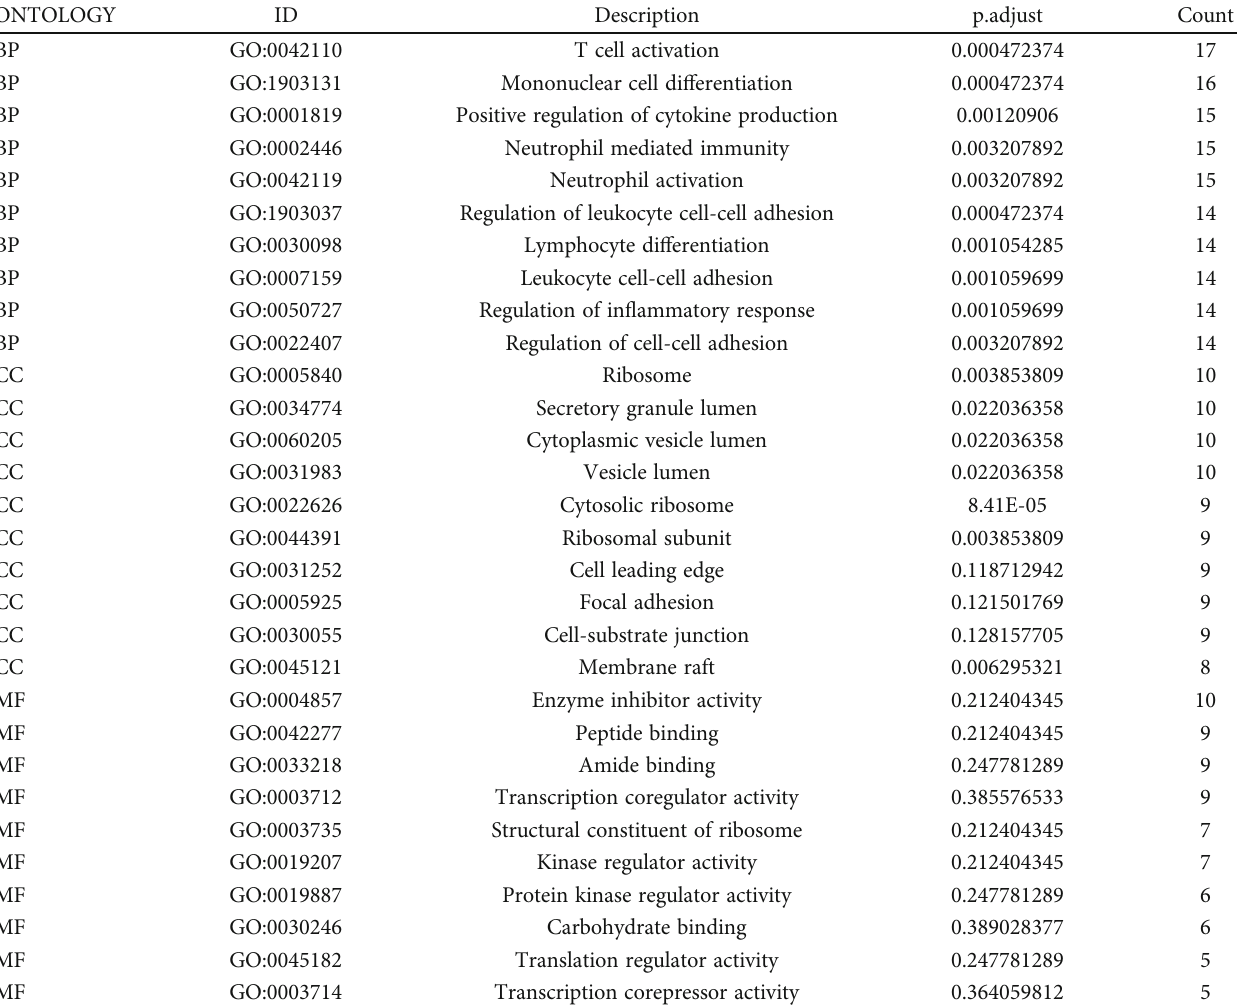
Table 2: The top 10 GO enrichment terms of genes in turquoise module.